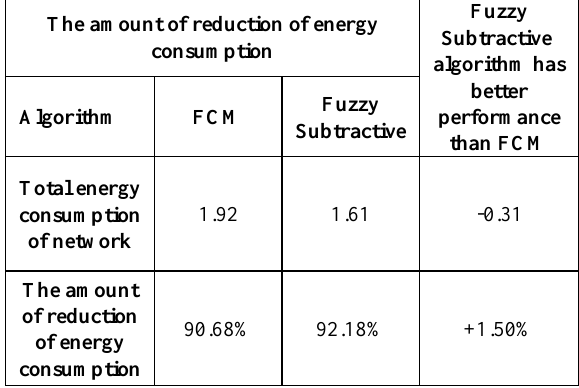
Table 3. Comparison of the best performance of the FCM and Fuzzy Subtractive algorithms in decreasing the amount of energy consumption of